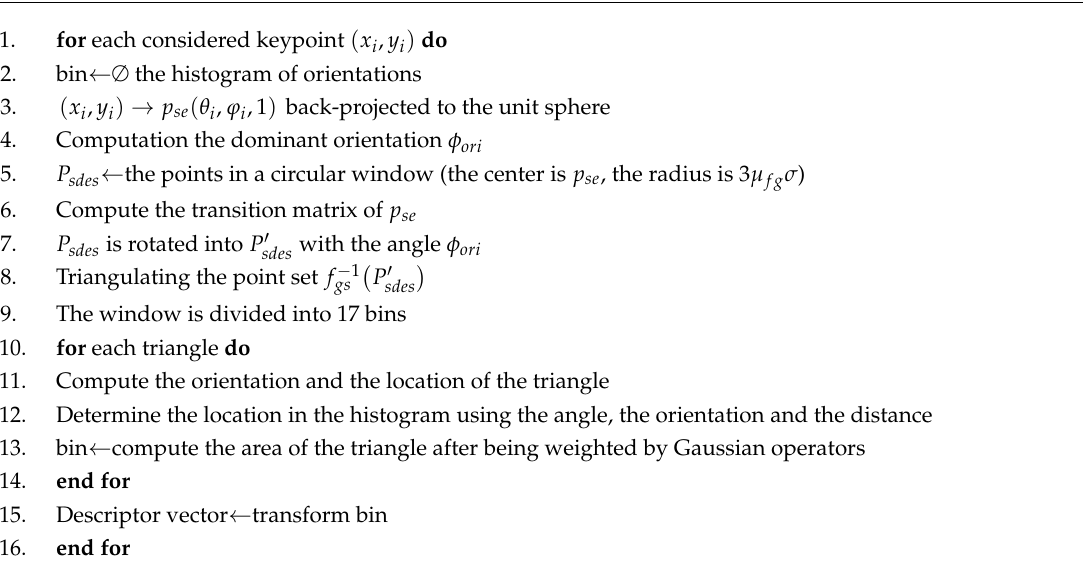
Algorithm 2 Algorithm for the computation of